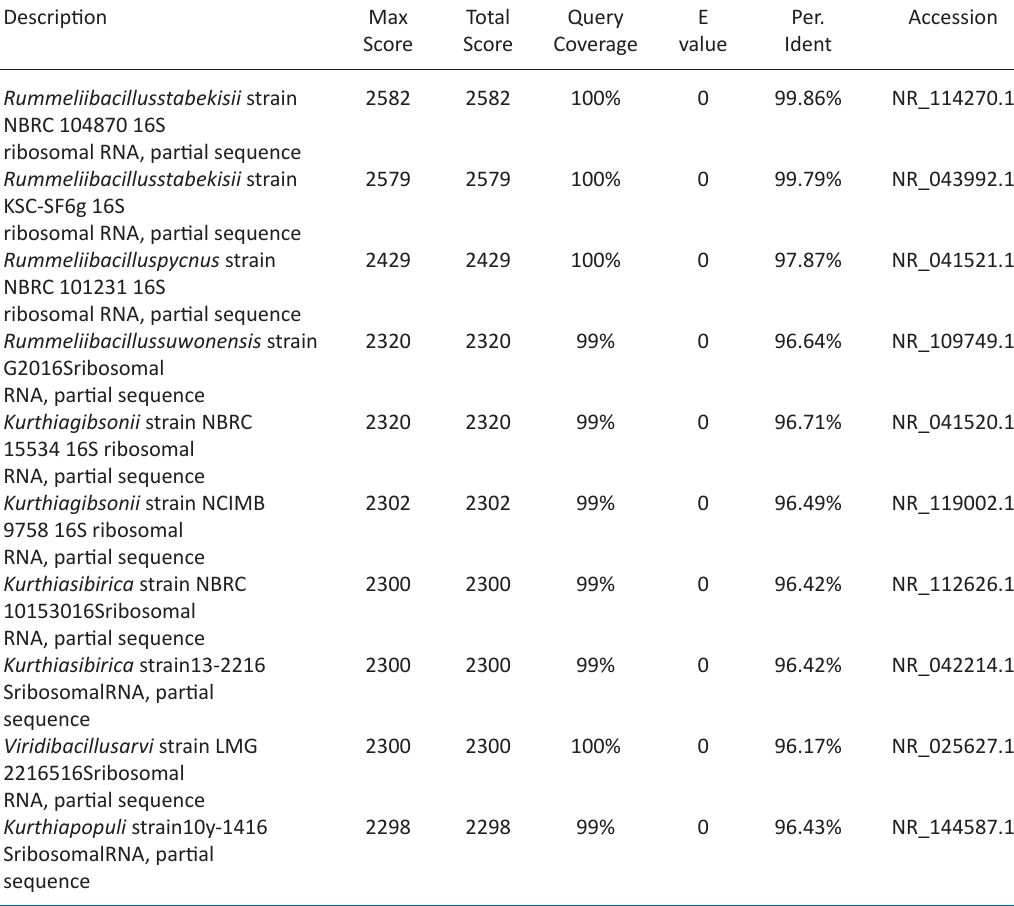
Table 5. Sequences producing significantalignments in BLAST